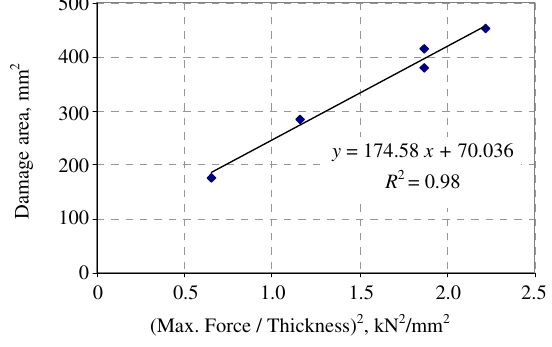
Fig 7. Damage area plotted against the maximum force normalized with